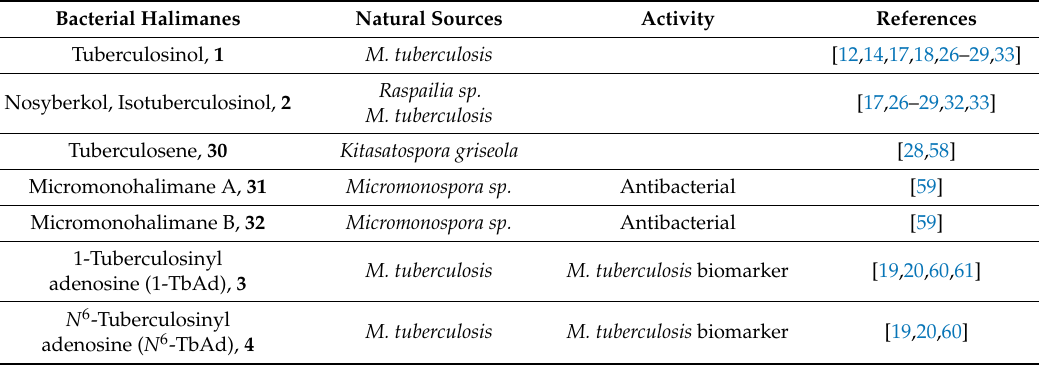
Table 4. Natural sources, activities of halimanes from bacteria.